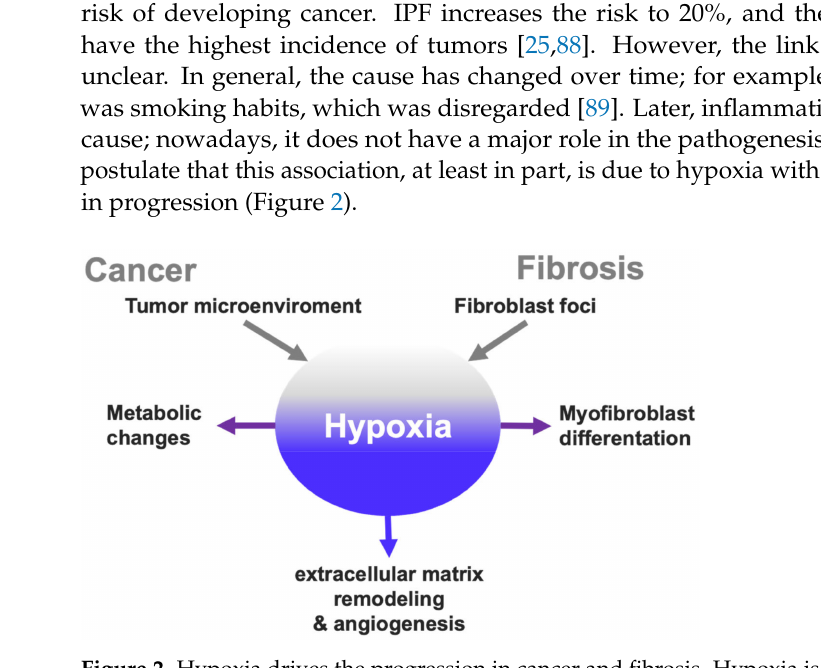
Figure 2. Hypoxia drives the progression in cancer and fibrosis. Hypoxia is an important part in the integration of the microenvironment signals; both tumors and fibroblast foci induce an activation of hypoxia and this in turn activates different mechanisms involved in its